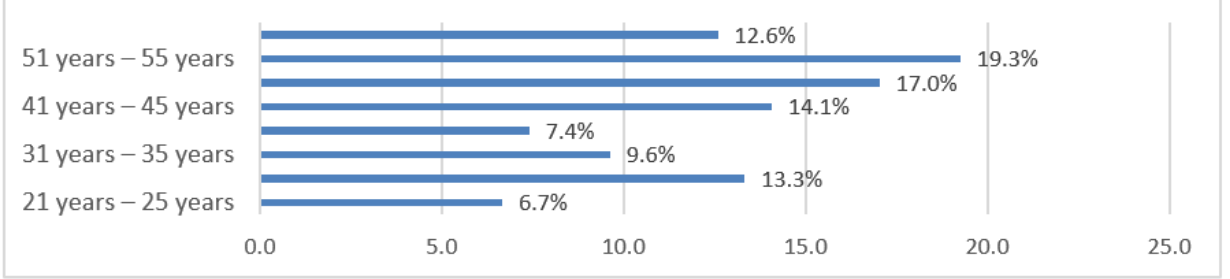
Figure 2. Respondent’s age groups.